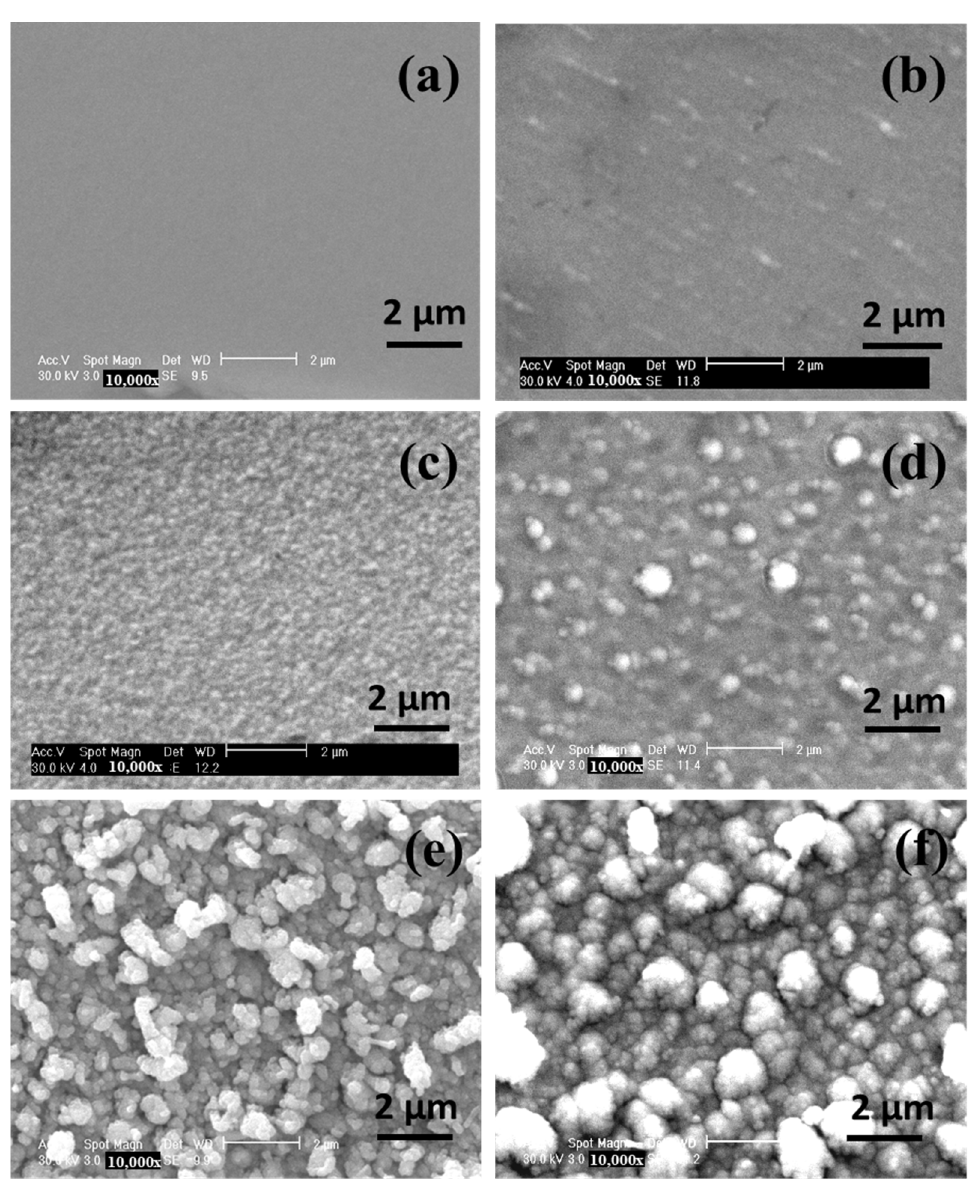
Figure 3. SEM image of TaN/Cu nanocomposite coatings with varying copper content (at.%): ( a ) 0, ( b ) 1.42, ( c ) 10.46, ( d ) 25.54, ( e ) 30.04, and ( f ) 35.